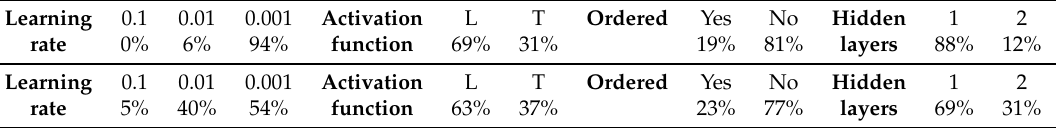
Table 15. Parameter metadata for the best model from each variable batch. The upper row is for the domain-specific approach and the bottom row is for the algorithmic